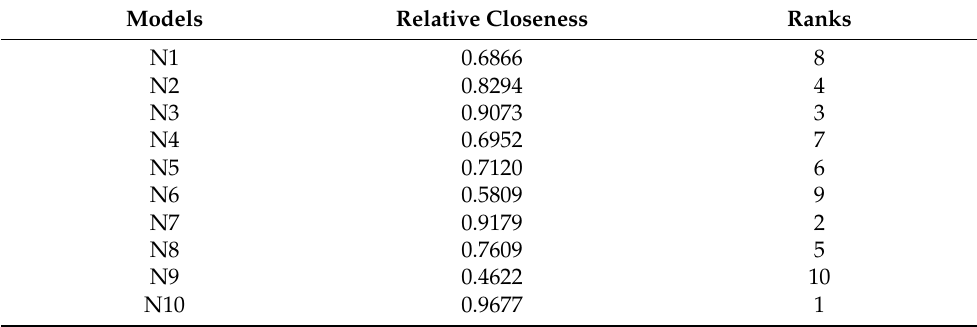
Table 10. Ranking normalization in Legendre network for Bitfinex dataset.